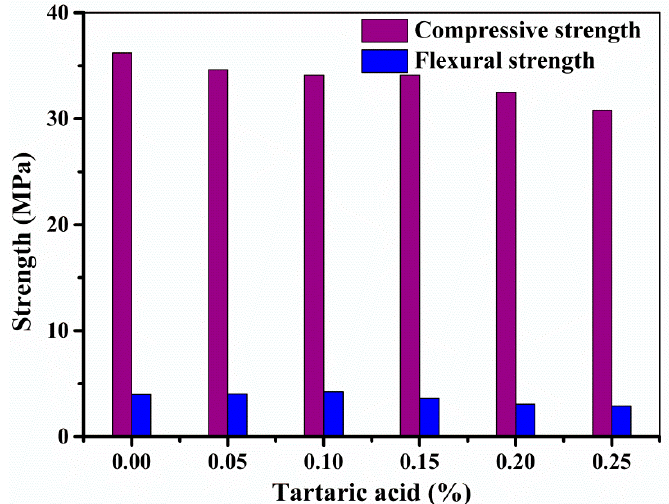
Figure 12. The compressive and flexural strength of the SAC with different additions of tartaric acid after curing 1 day.